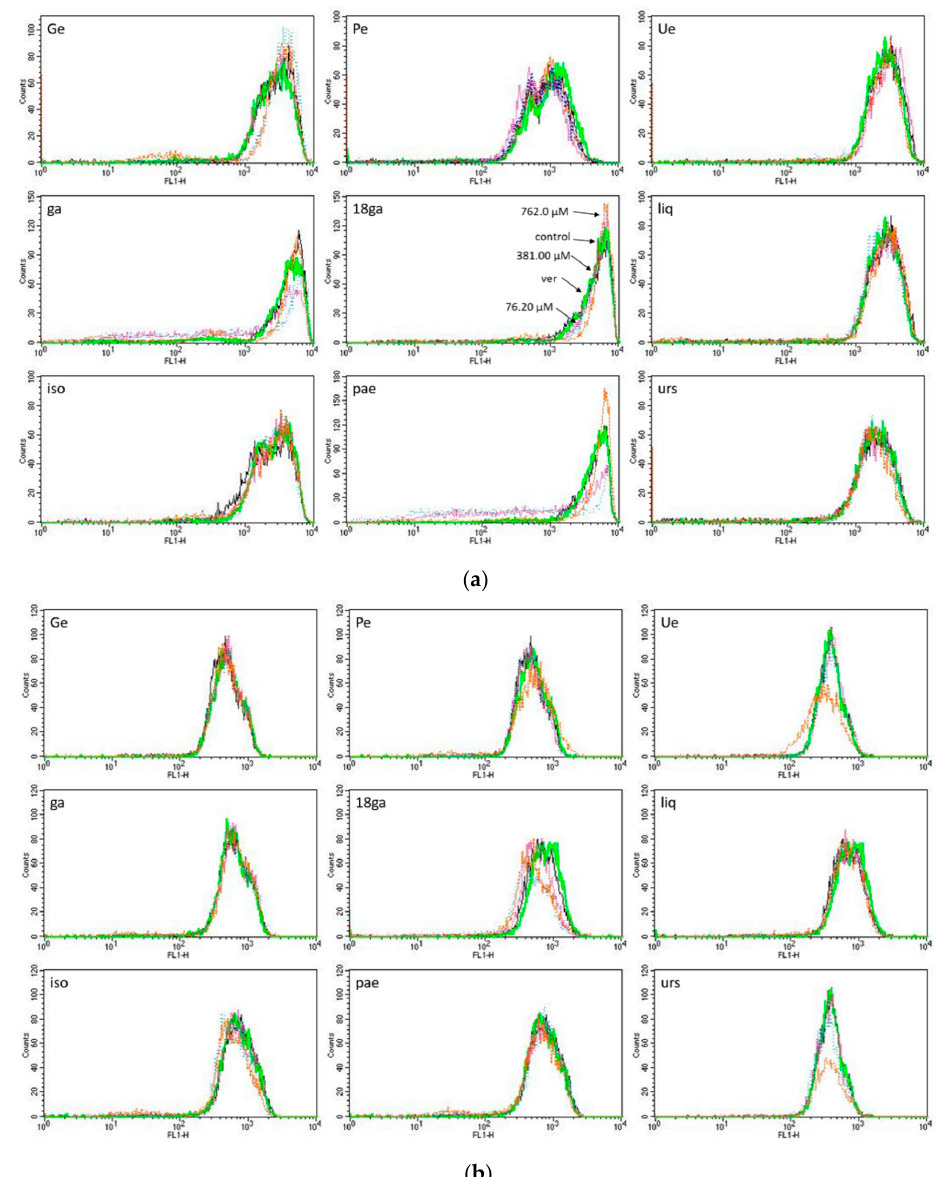
Figure 2. Histograms of flow cytometry of calcein-AM ( a ) and rhodamine 123 ( b ) retention in CEM/ADR 5000 cells after 1.5 h treatment with three concentrations (IC 50 , IC 50 × 5, and IC 50 × 10) of a single substance compared to the treatment with 50 µM verapamil (positive control). All experiments were repeated at least three times.